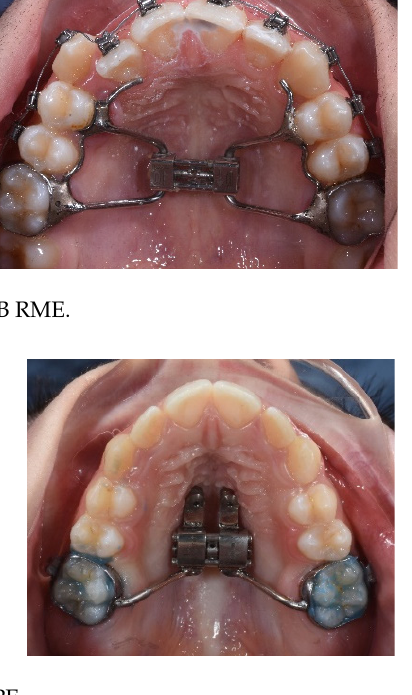
Figure 2. MARPE appliance: BB MARPE and TBB MARPE.